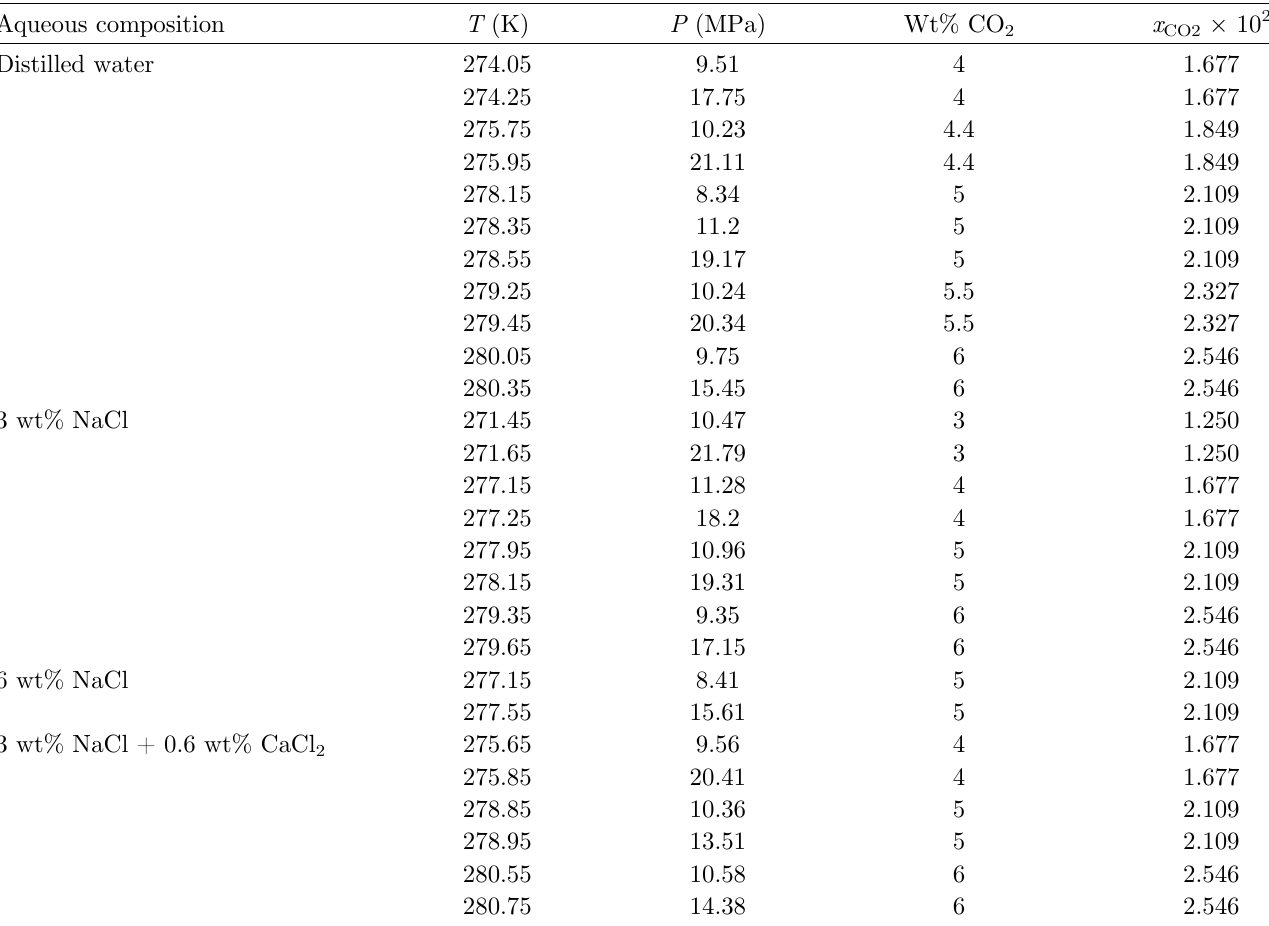
Table 5. Hydrate equilibrium temperatures at HL concentration is on free-salt basis and mole systems (CO 2